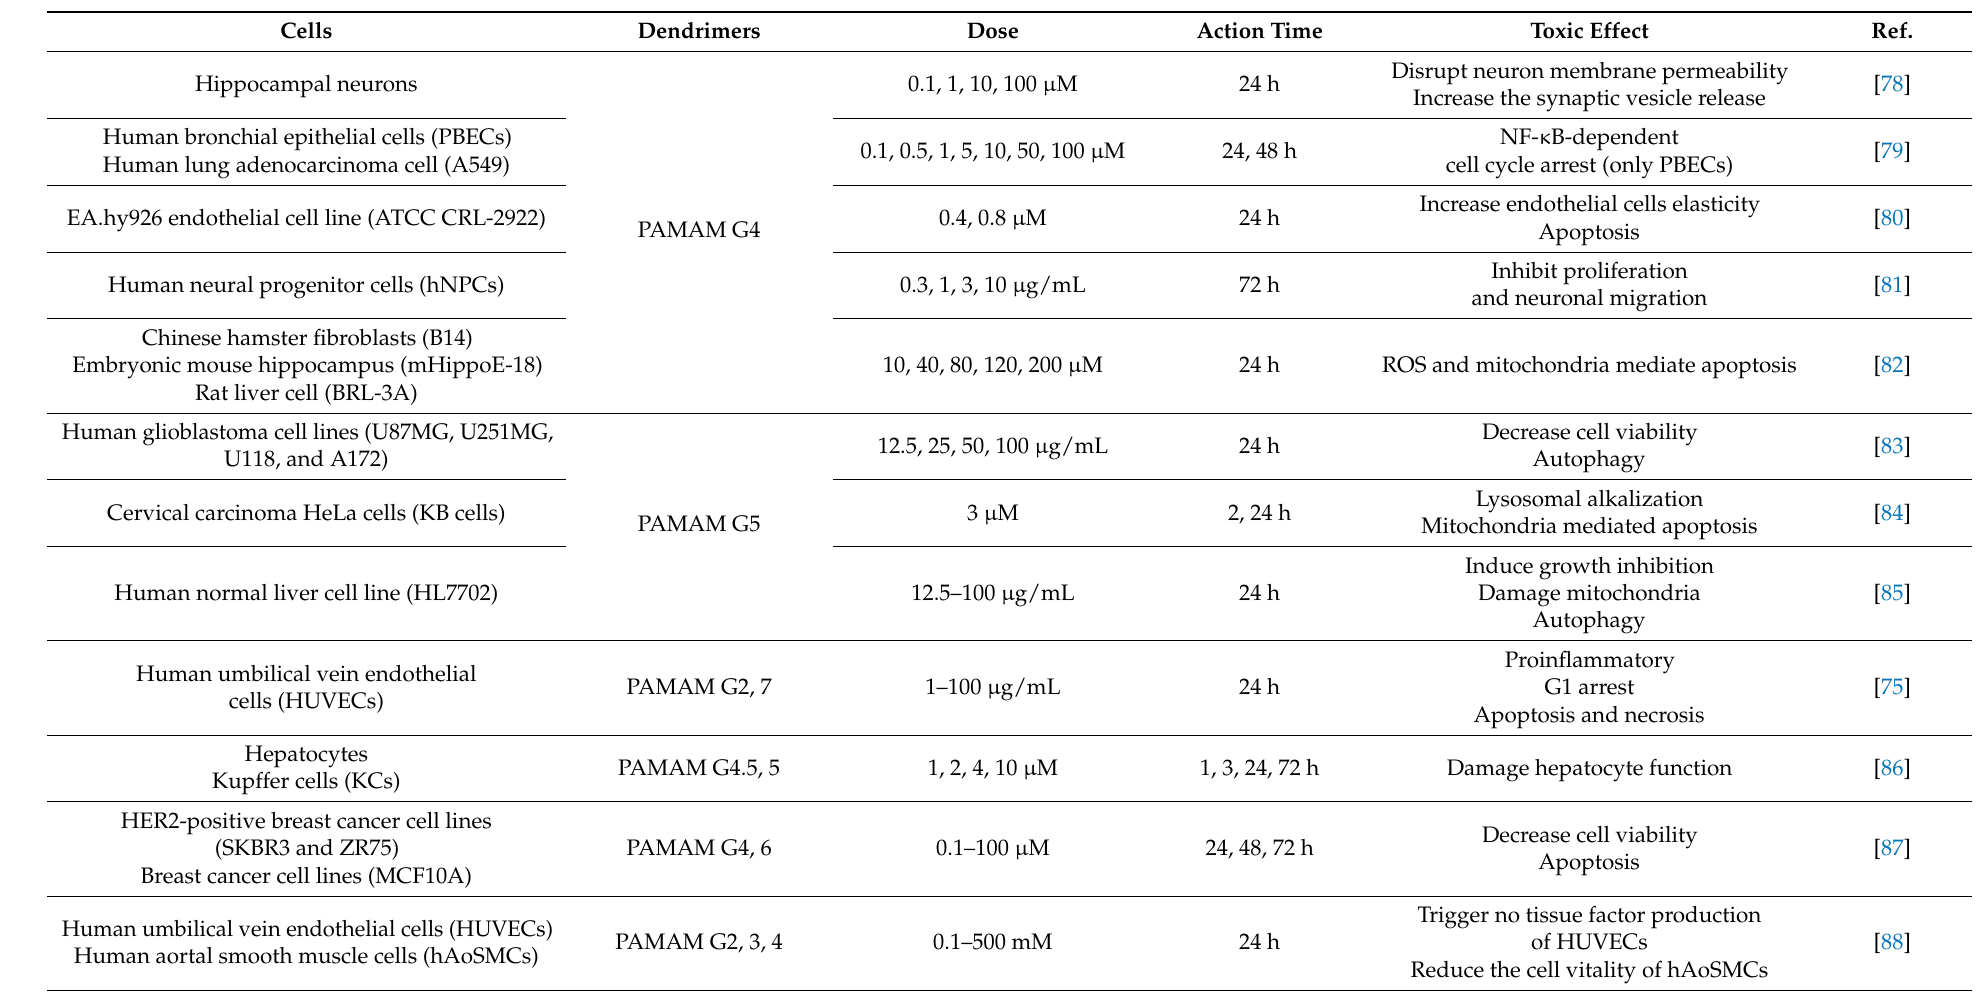
Table 1. Toxicity of dendrimers for different cell